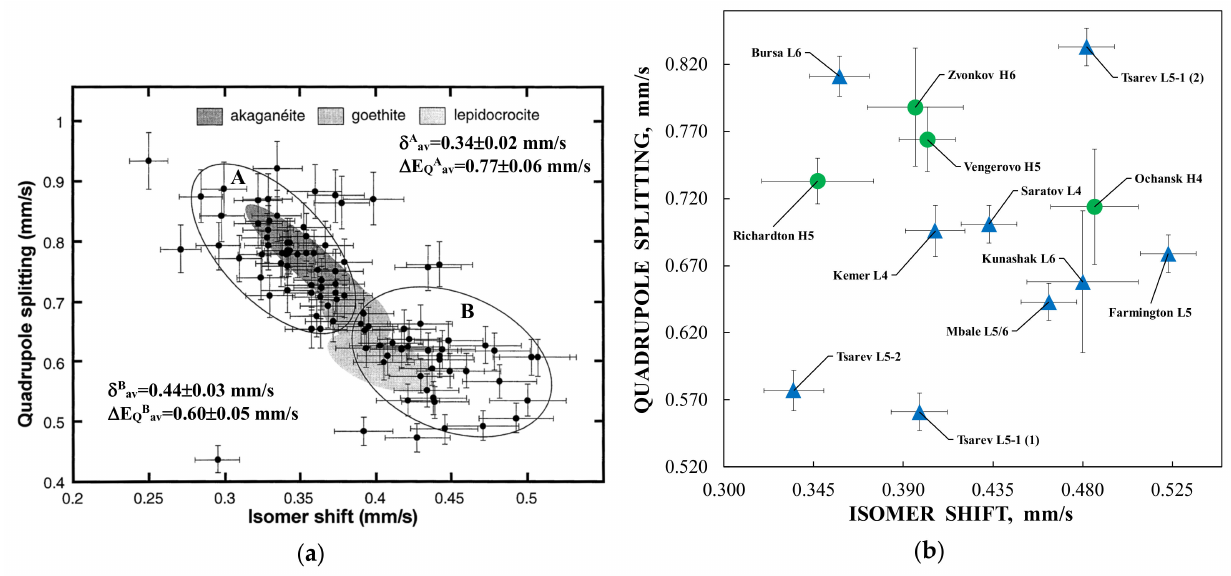
Figure 47. Comparison of the room temperature 57 Fe hyperfine parameters for ferric compounds found in the weathered ordinary chondrites Mössbauer spectra measured with a low ( a ) and a high ( b ) velocity resolution. The plot ( a ) was adapted from Reference [125]. Data in the plot ( b ) were taken from References [83,98,100,101], —H ordinary chondrites, —L ordinary chondrites.